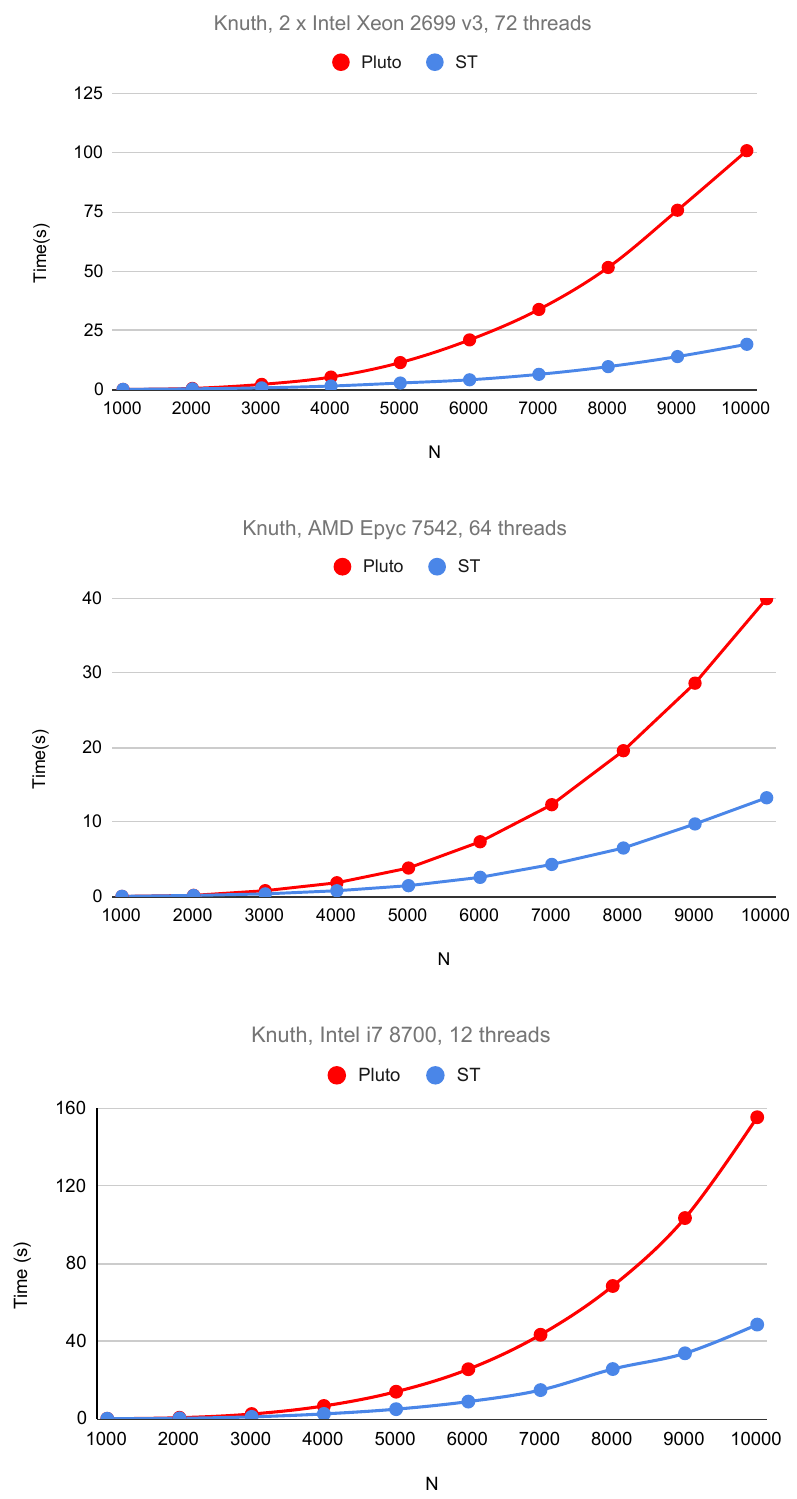
Figure 4. Running times of the parallel tiled Knuth OBST implementations generated by applying space-time tiling and